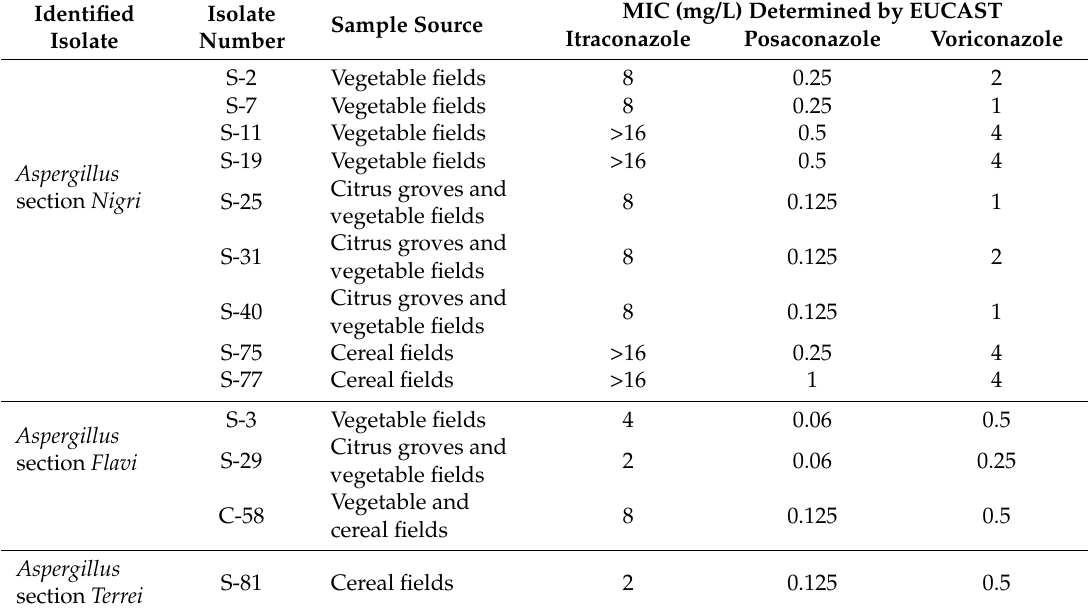
Results of EUCAST (European Committee on Antimicrobial Susceptibility Testing) susceptibility testing for 13 Aspergillus spp.